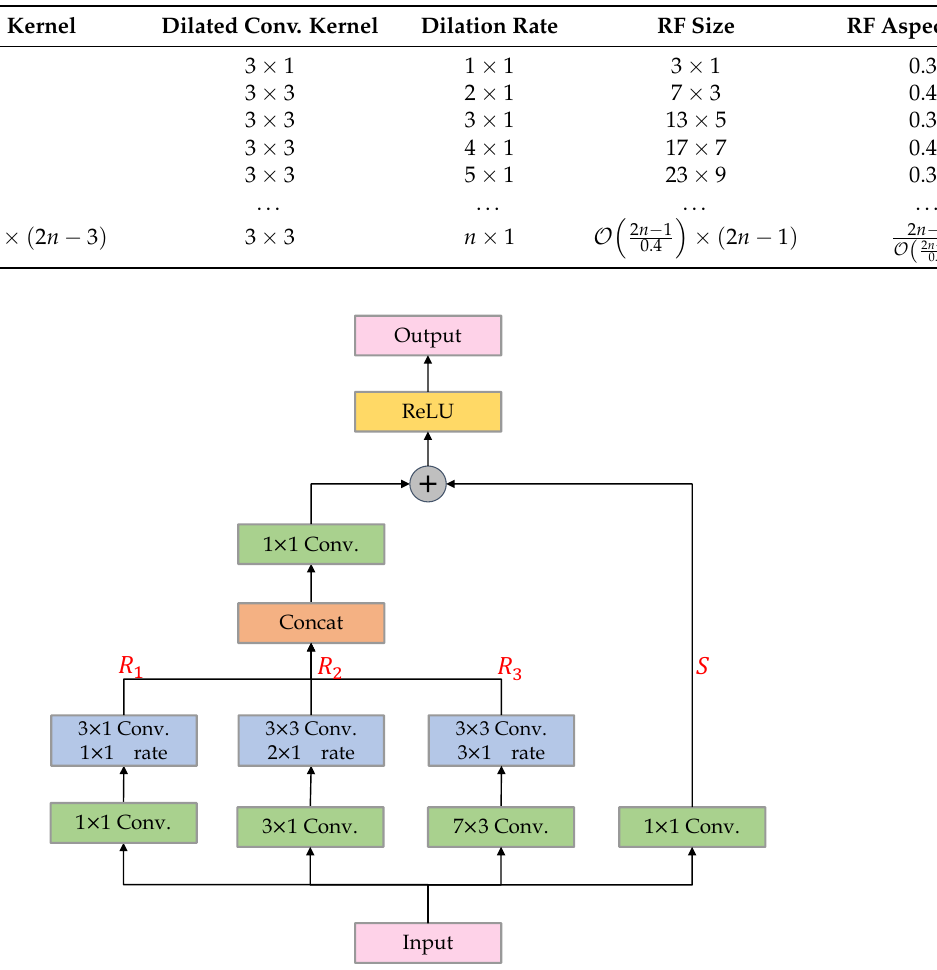
Table 1. According to the fixed aspect ratio of pedestrians (0.4), the convolution parameters are listed to construct an RF with a similar shape. The input RF size is 1 × 1. O ( · ) denotes an approximation to the nearest odd integer.